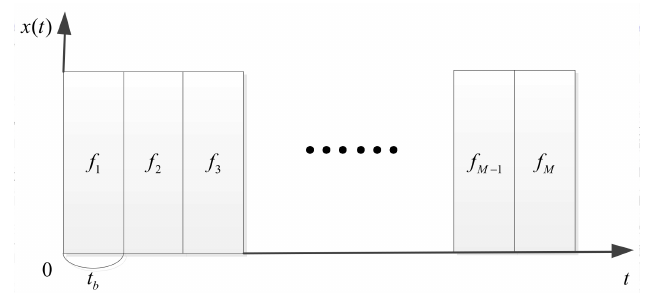
Figure 3. The sketch map of the IPFC signal.